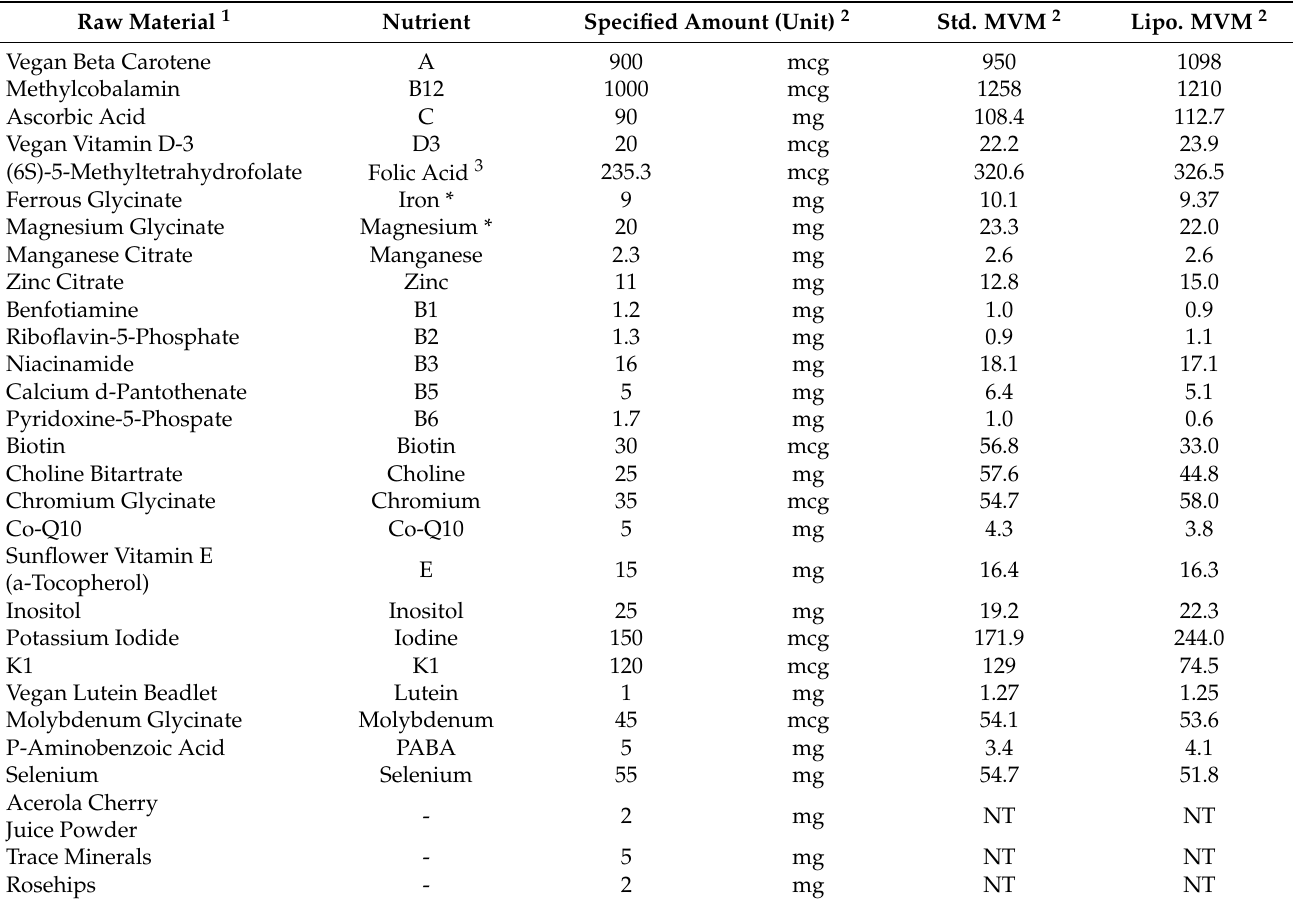
Table 2. Nutrient content of multivitamin/mineral